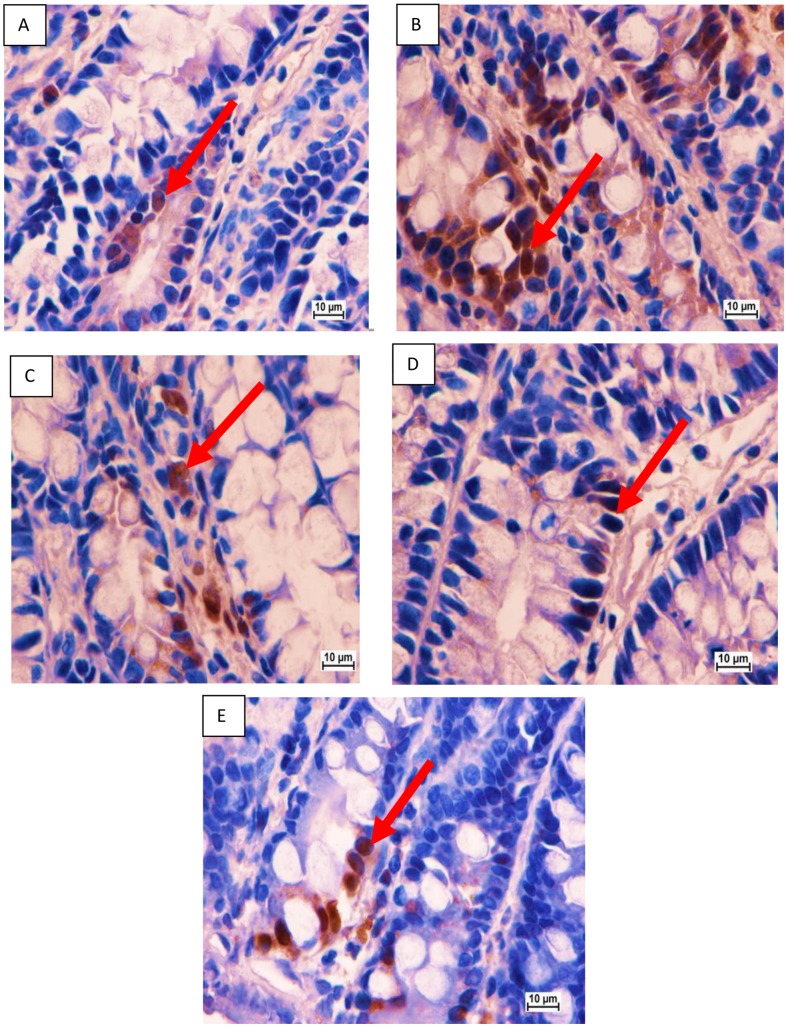
Effects of A. ilicifolius on PCNA Staining.All sections were cut parallel to the muscular layer. The immunohistochemical staining method was used to detect PCNA-labelling indices (PI) in specimens with AOM-induced ACF in colon tissue including those fed with A. ilicifolius. PCNA-negative cells were (stained blue) and PCNA positive cells were (stained brown). PCNA was evaluated as a marker for cell proliferation in the colon specimens. Sections of colon samples from the control group and A. ilicifolius-treated groups. The PCNA labelling index (PI) was calculated as the [(number of positive cells)/(total number of epithelial cells)]×100 for each field. (A) Normal control group showed significantly lower PCNA indices compared to AOM control group (arrow). (B) AOM-control group showed significantly higher PCNA indices than those in groups C, D, and E (arrow). (C) 5-Fluorouracil (standard drug)-fed group + AOM showed significantly lower PCNA indices than AOM-control group. (D) Rats fed with 250 mg/kg A. ilicifolius + AOM, showed significantly lower PCNA indices than the AOM control group (arrow). (E) Rats fed with 500 mg/kg A. ilicifolius + AOM showed significantly lower PCNA indices than AOM-control group (Immunohistochemical (PCNA) staining X100).